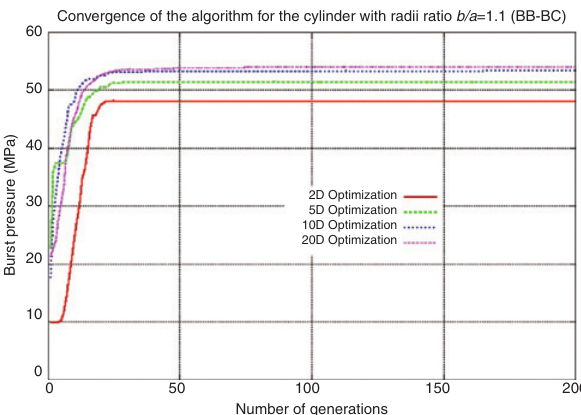
Figure 7: Convergence of BB-BC algorithm for the pressure vessel with a radii ratio b / a = 1.1.